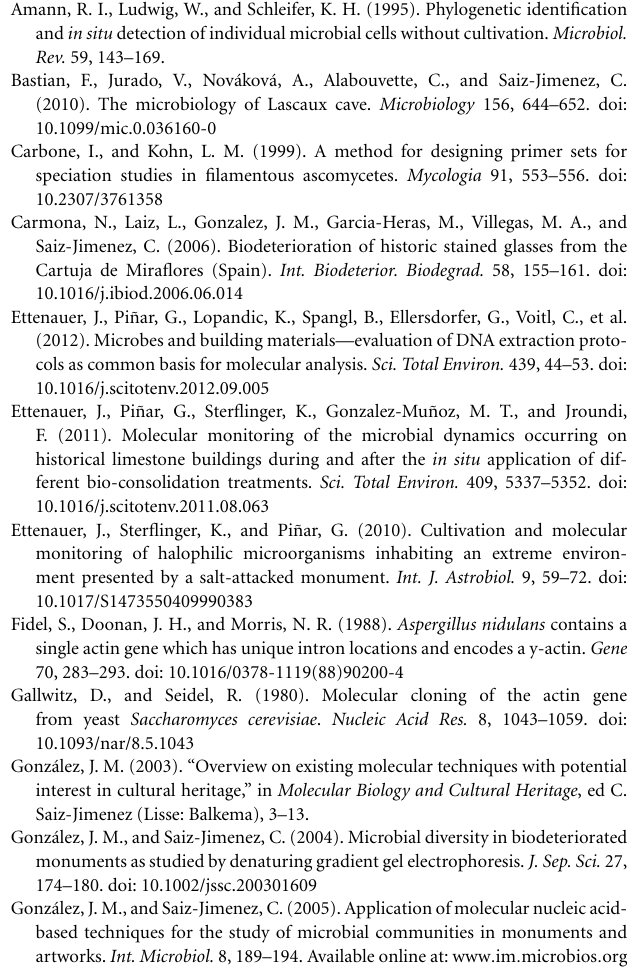
Figure S1 | Representative curves showing the primer-specific quantification curves (A), standard curves (B), melt peak curve (C) and melt curve (D). Table S1 | Summary of the cultivation results from our previous study (Sterflinger et al., 2013) for the insulation materials: calculated